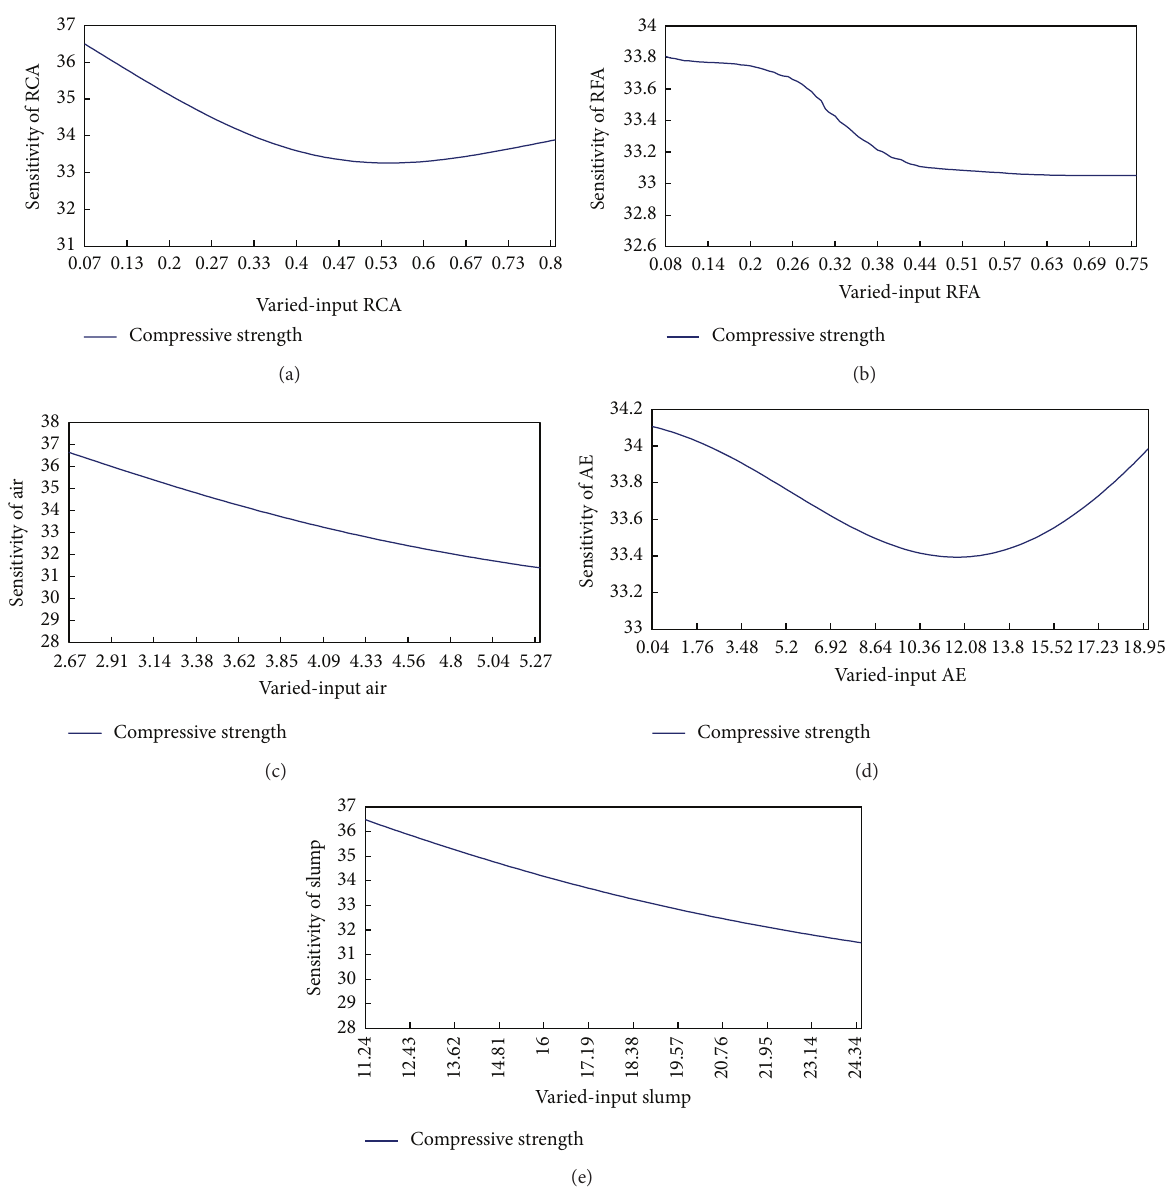
Figure 7: Sensitivity of the input parameters to the compressive strength, showing the effect of varying the input value on the parameters.